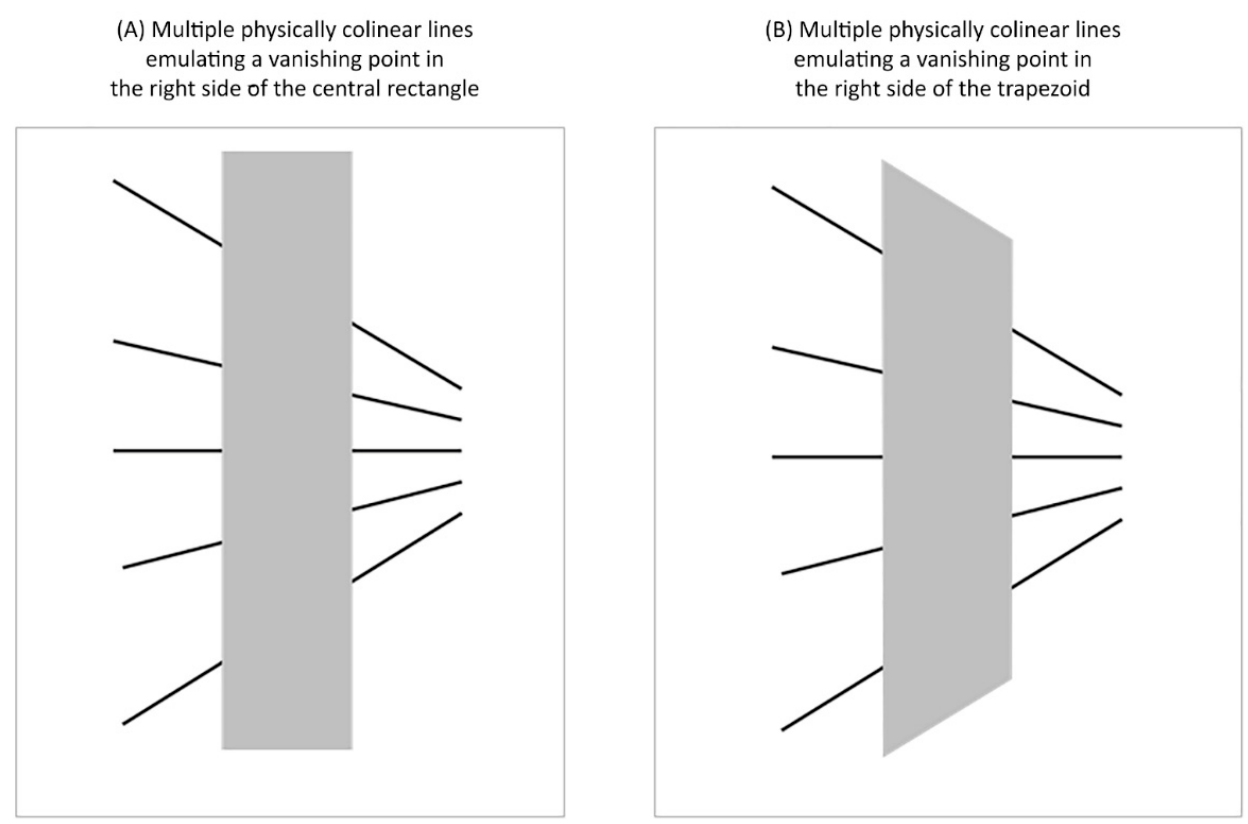
oblique lines receding in the distance that creates an apparent misalignment in the oblique lines. In other words, when the central area is not perceptually rescaled, the absence of this pictorial depth cue creates an uncertainty about the positions of the receding lines in 3D space, which in turn causes an increase in the magnitude of their perceived misalignment. Similar to these ideas, Gillam [11] demonstrated that the strength of a typical Poggen- dorff illusion in Figure 12A is stronger than the variant in Figure 12B. She argued that this was due to a decrease in the certainty of the oblique lines representing continuous lines receding in the distance in the former case. Thus, according to Gillam, one way to diminish uncertainty about collinearity would be to increase the number of pictorial depth cues in the scene. In line with her predictions, we demonstrated that the strength of the Poggendorff illusion decreased as pictorial depth cues were added to the image display.